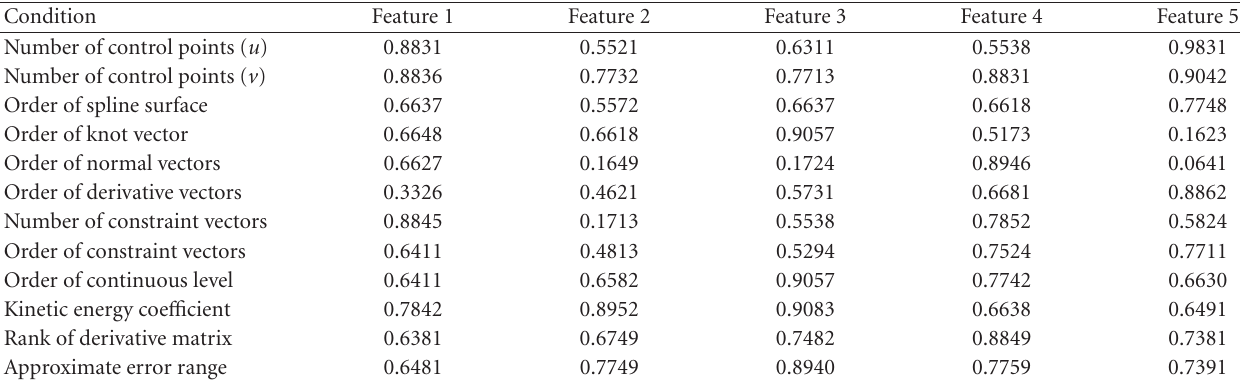
Table 11: Fuzzy relation degrees between experimental condition parameters and kinetic energy distribution surface features trigonometry Bernstein-Bezier surface.